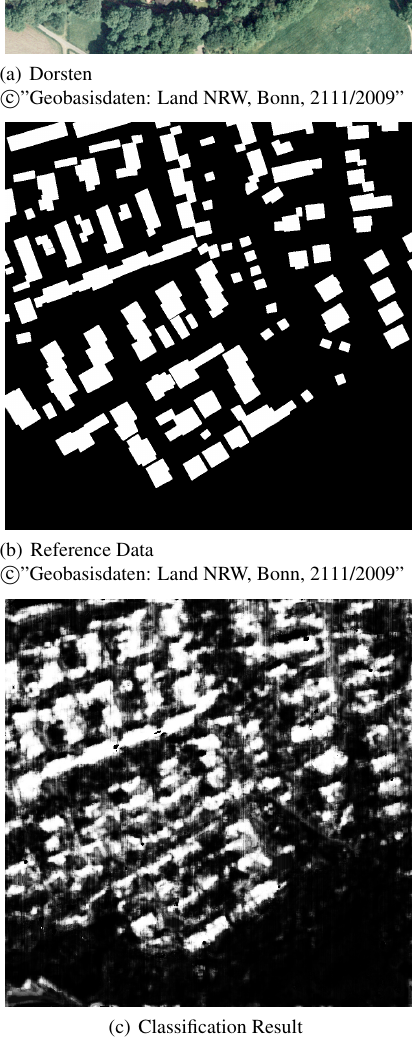
Figure 3: Image and reference data, as well as classification result number of clusters was fixed to 50 . To calculate the texton his- togram window size was set to 10 . Codebook generation as well as the training of the classifier were performed using a different part of the dataset. Figure 4 shows the ROC statistics of the proposed color-textons (green), the standard gray-value textons (red), as well as another approach (blue) to include color information into the texton frame- work by simply applying the filter-bank to all channels individ- ually. The according error rates are estimated by 4 -fold cross-